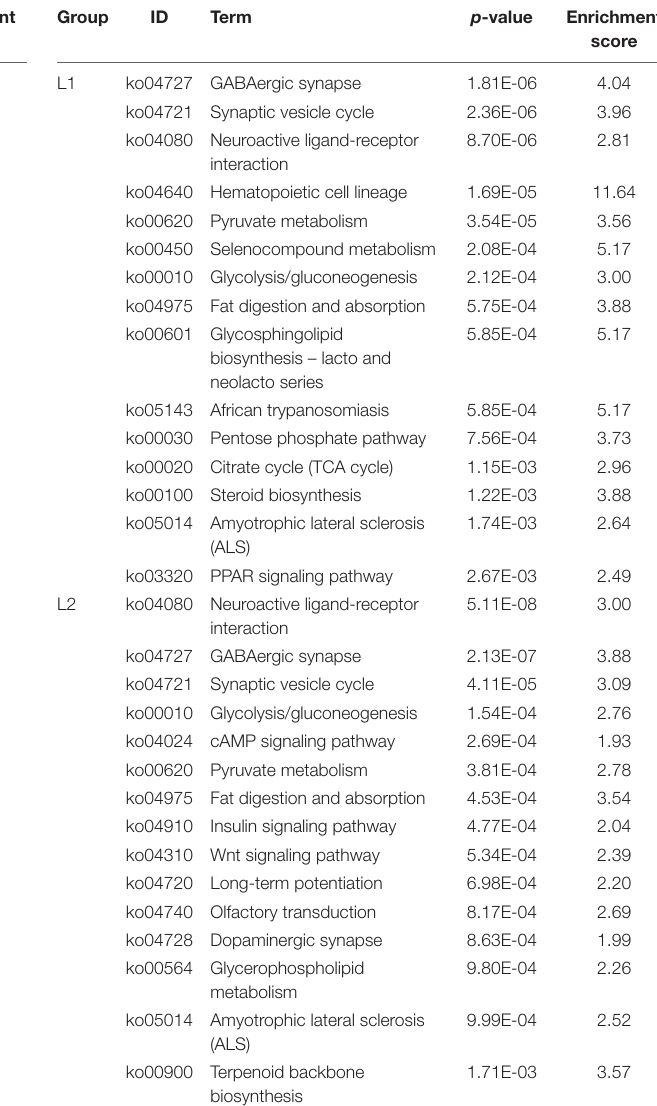
TABLE 2 | The top 15 upregulated KEGG pathways in the L groups. TABLE 3 | The top 15 downregulated KEGG pathways in the L